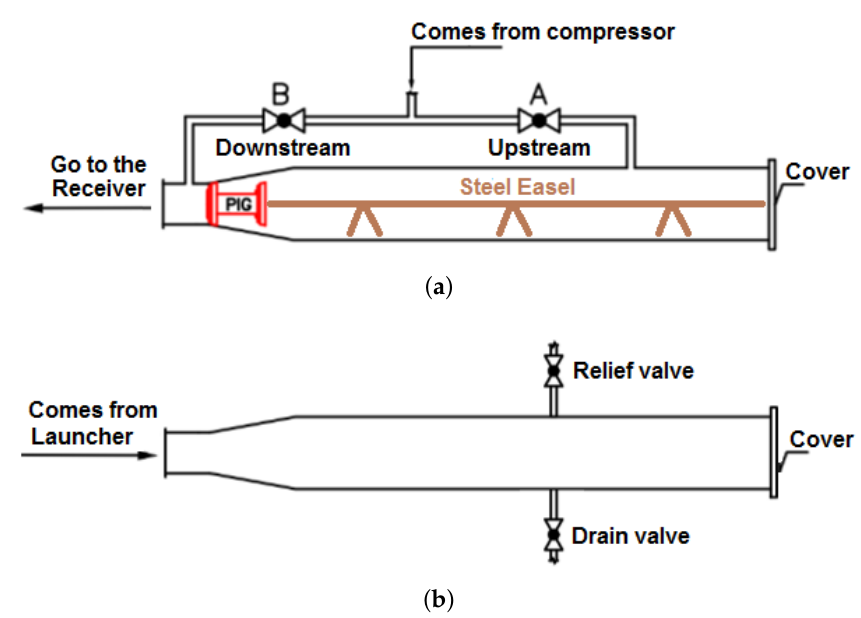
Figure 10. Continuation of procedures with PIG. ( a ) opening ball valves in the φ 8” launcher; ( b ) opening ball valves in the φ 8” receiver. Source: Adapted From [15].